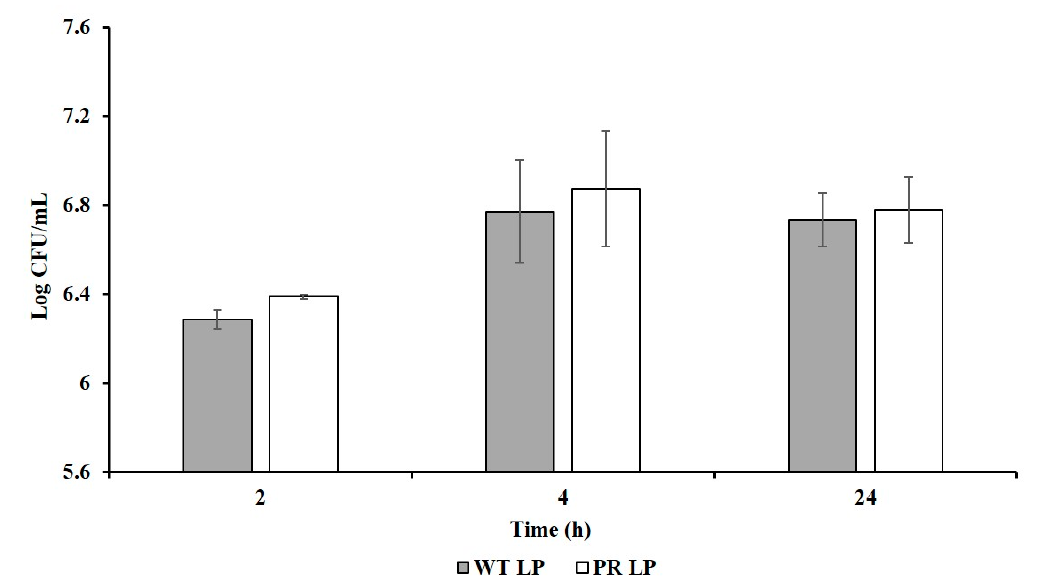
Figure 4. Adherence ability of wild-type LP and LP + PR strains to INT-407 cells. Error bars indicate standard deviation from 6 parallel trials.